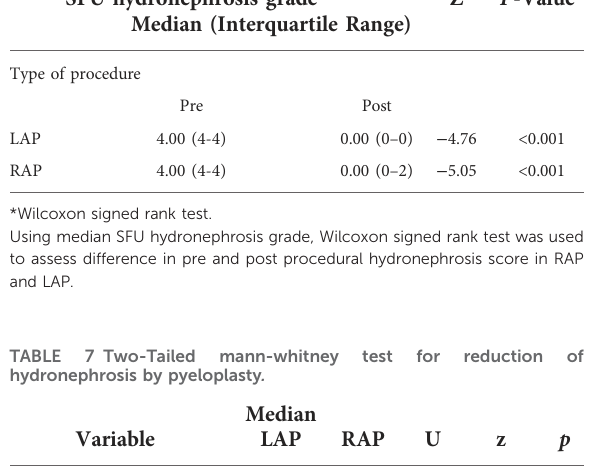
Table 6 Median hydronephrosis